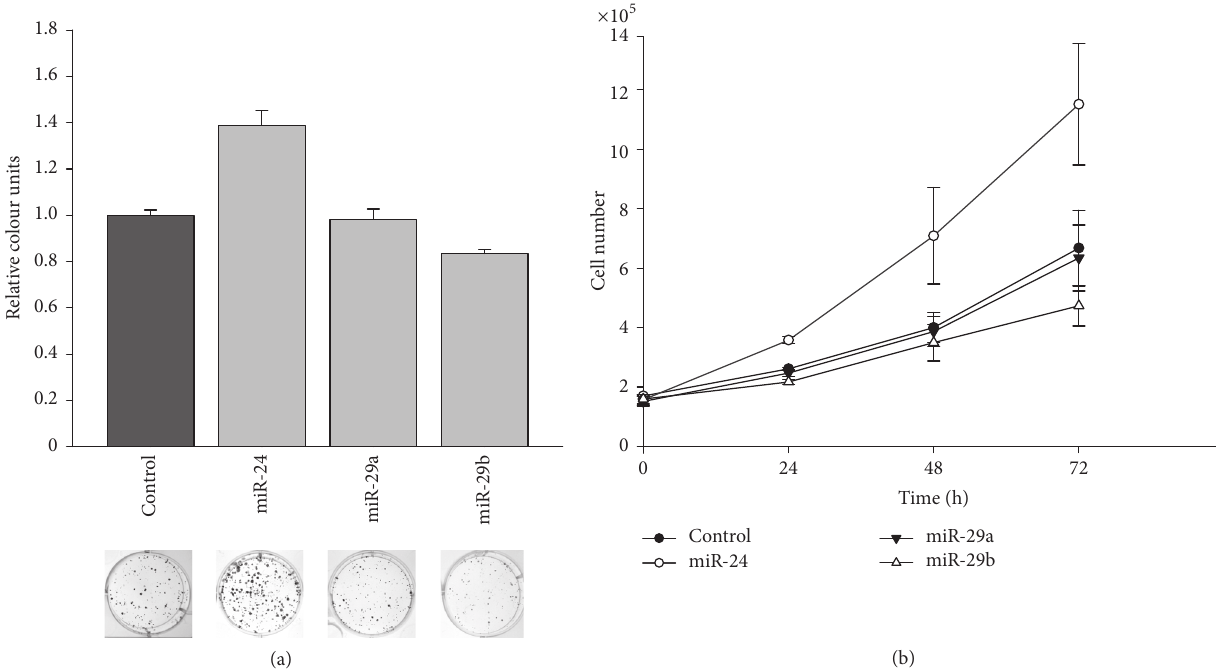
Figure 6: Effect of miR-24 and miR-29a/b on cell growth. DU145 cells were transfected with miRNA expression vectors or control vectors and seeded in a limited cell number. Eight days after seeding, colonies were stained with crystal violet (a). Colony formation was quantified by densitometry analyses. Data show the mean and ± SEM of the densitometry analysis of CFA ( 𝑝 < 0.001 ) of three independent experiments. Cell growth was determined by automated cell counting of parallel experiments at 24, 48, and 72 h after transfection